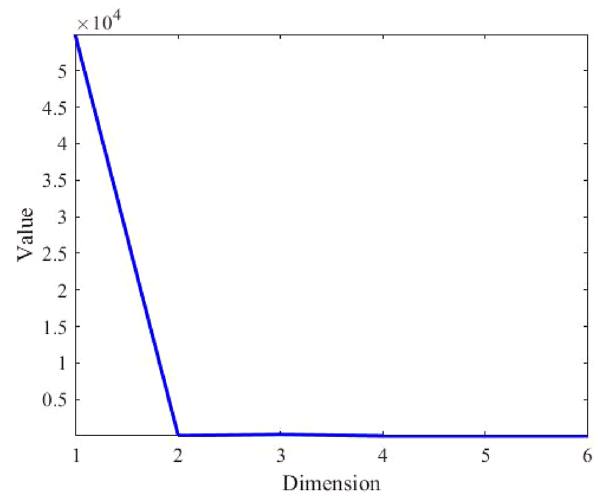
Fig. 7 Population iteration results